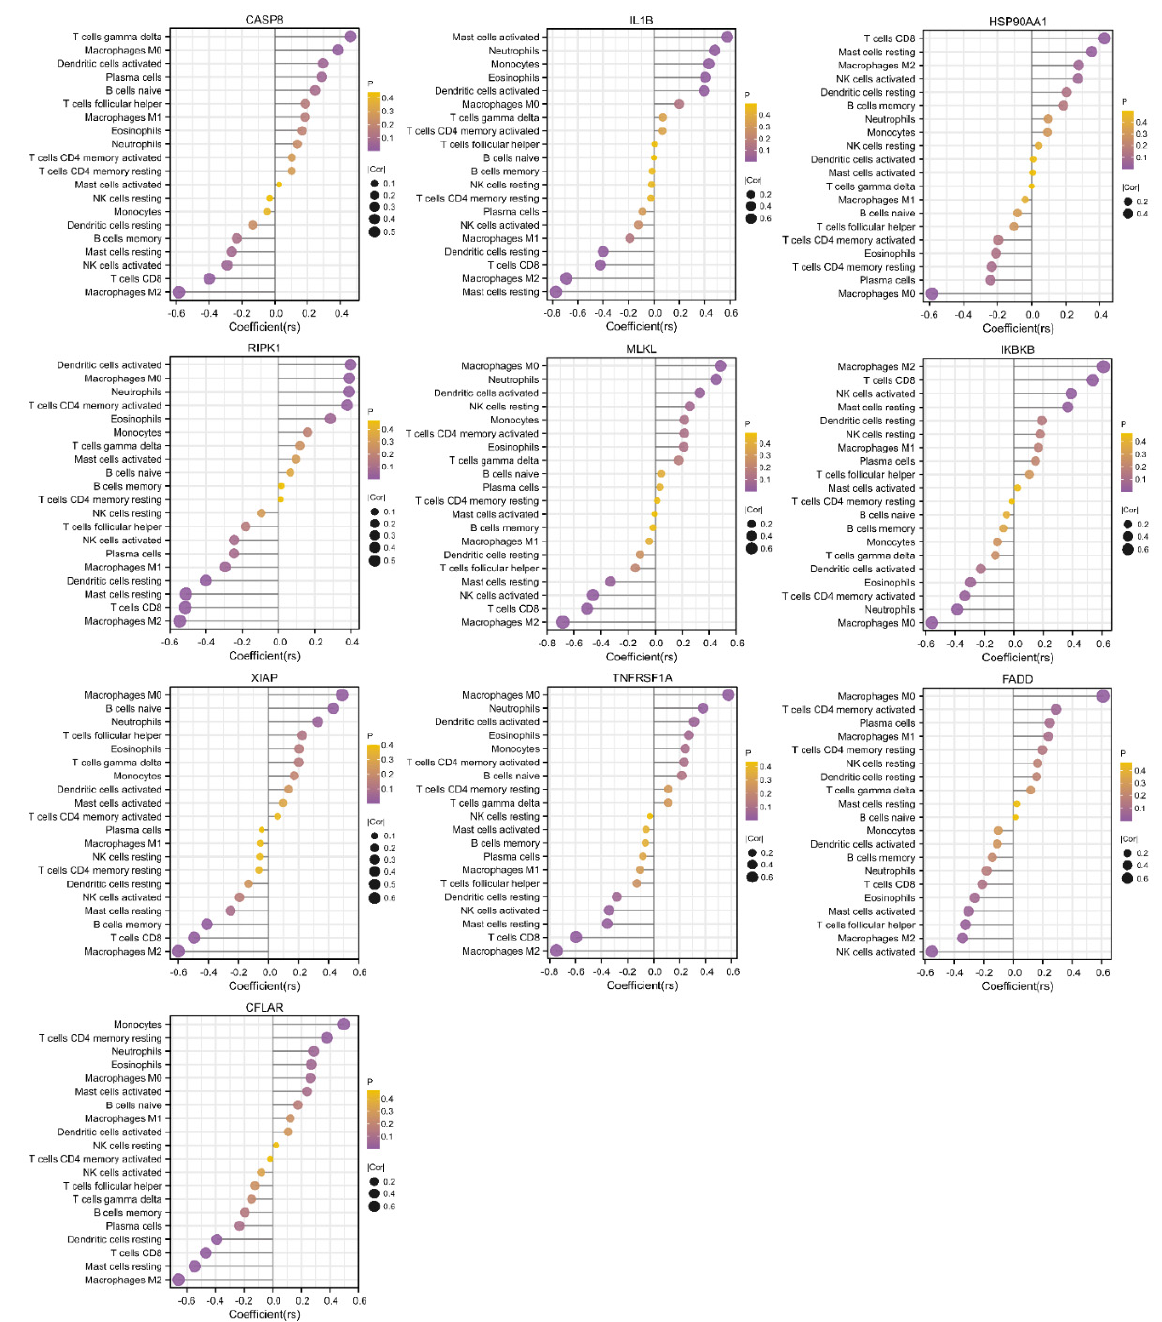
Figure 6. Correlations between hub genes and infiltrating immune cells. The size of the dot indicates the strength of the association between the gene and the immune cell type; a larger dot indicates a stronger correlation. The dot’s color represents the p -value; the more purple the color is, the smaller the p -value.